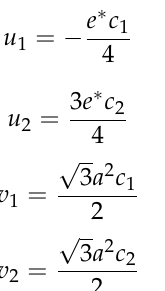
From here we can separate out Equation (4) into separate dipole moments and lattice volumes of the top C 1 -A 1 bond and the bottom 3 cation-anion bonds as Equations